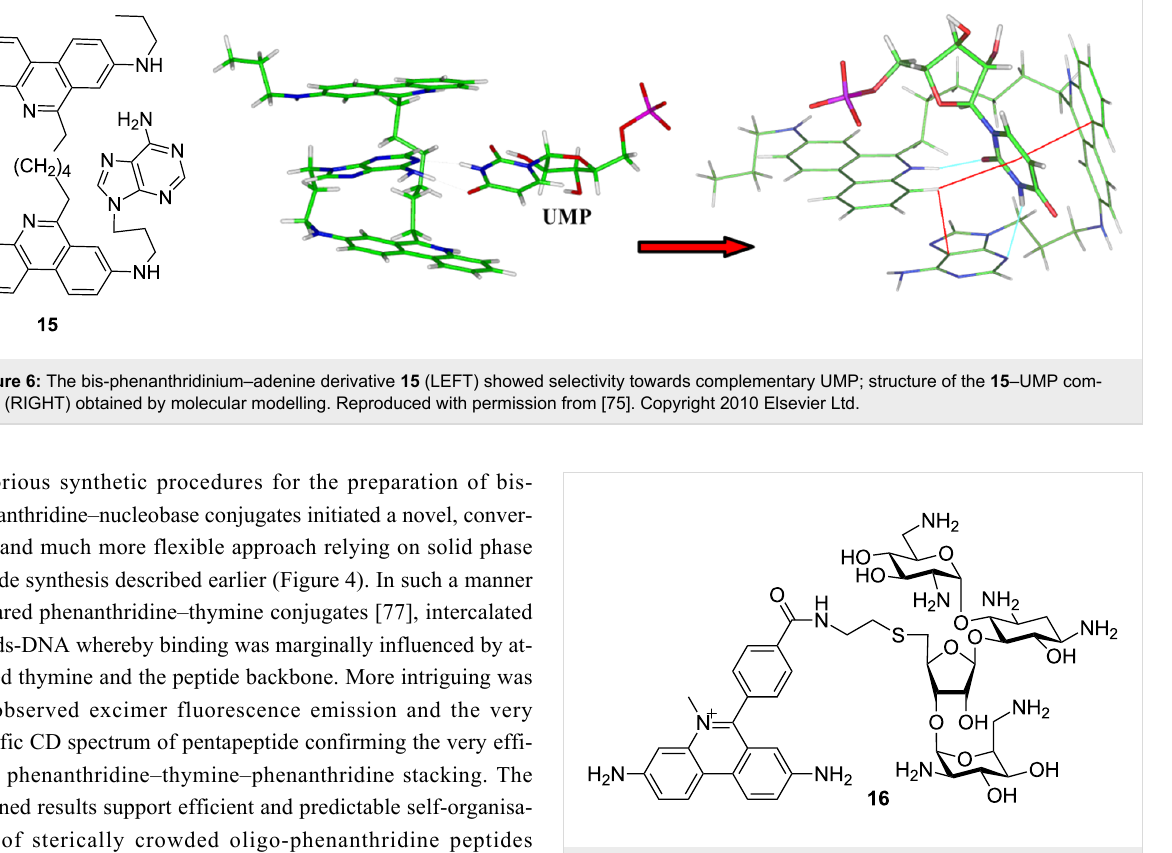
Figure 7: The neomycin–methidium conjugate targeting DNA:RNA hybrid structures [80].